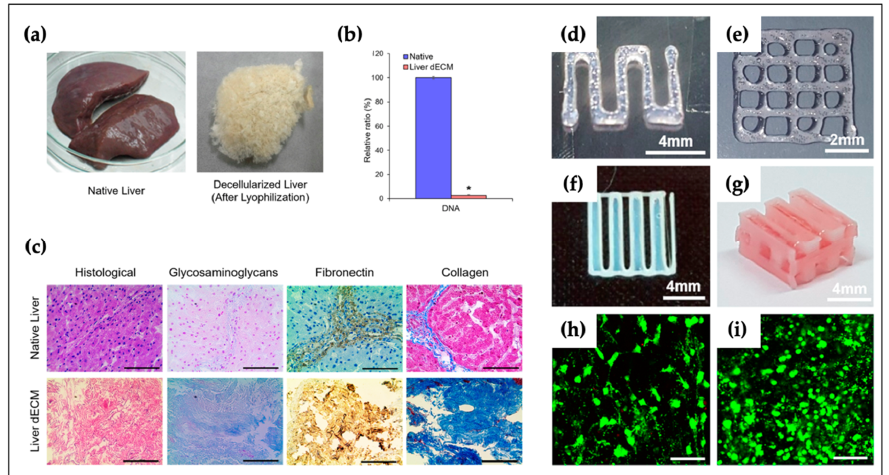
Figure 9. Development of liver-specific bio-ink for liver tissue engineering. ( a – c ) Evaluation of characteristics for liver-specific bio-ink relative to the native liver (*, p < 0.005; scale bar 100 um) ( d ) single line pattern and ( e ) 2D patterns; ( f ) 2D patterns using hybrid polymer and ( g ) 3D hybrid structures; ( h ) live/dead image of mesenchymal stem cell (MSC); and ( i ) HepG2 cell line. Adapted with permission from [189]. Copyright (2017) American Chemical Society.